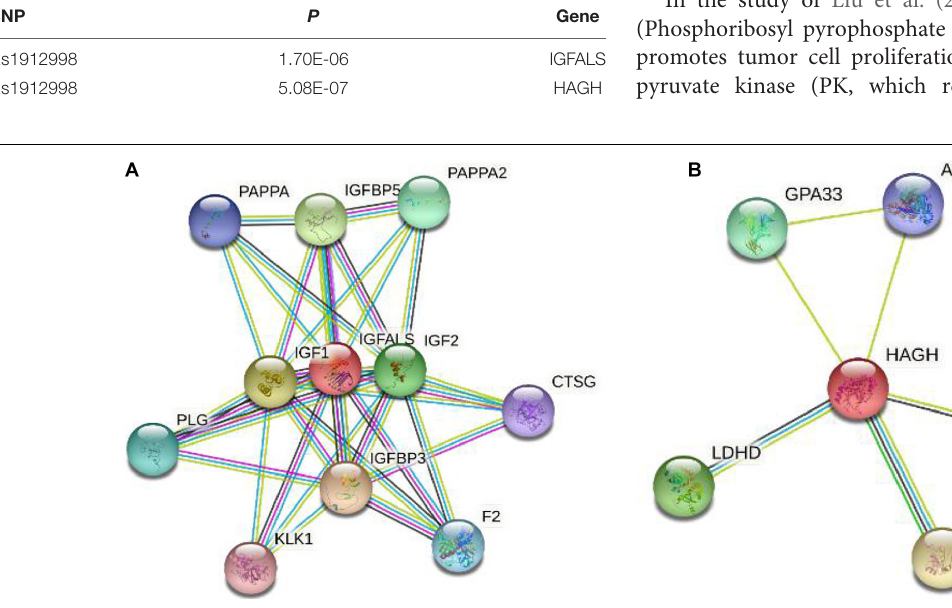
Frontiers in Cell and Developmental Biology |